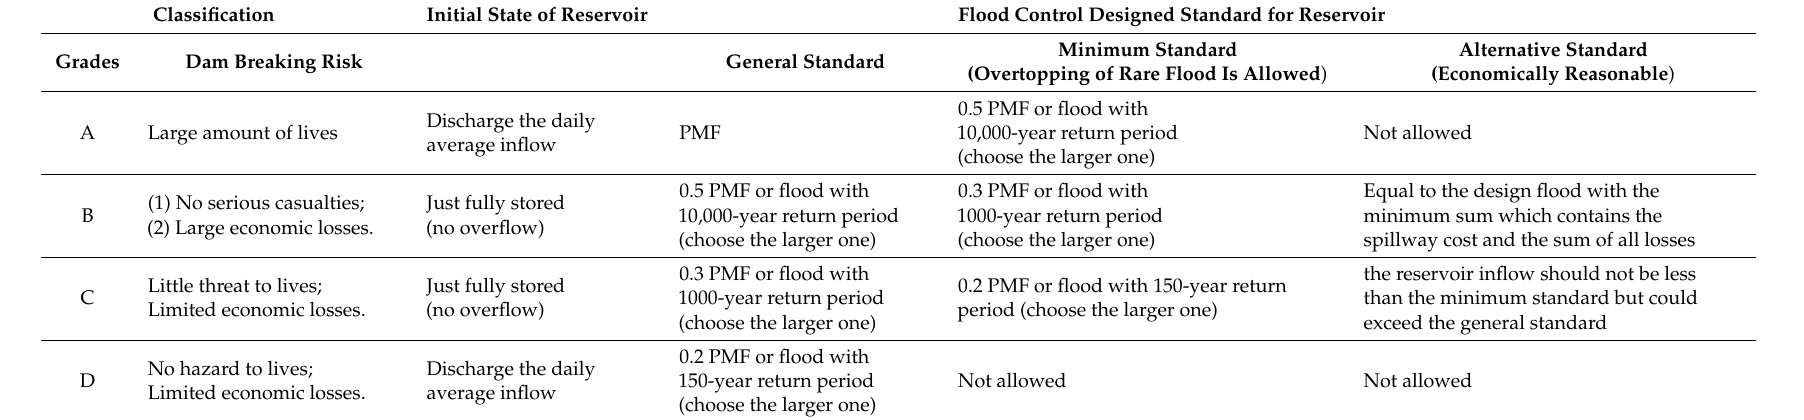
Table 9. Flood control design standard for reservoir engineering in